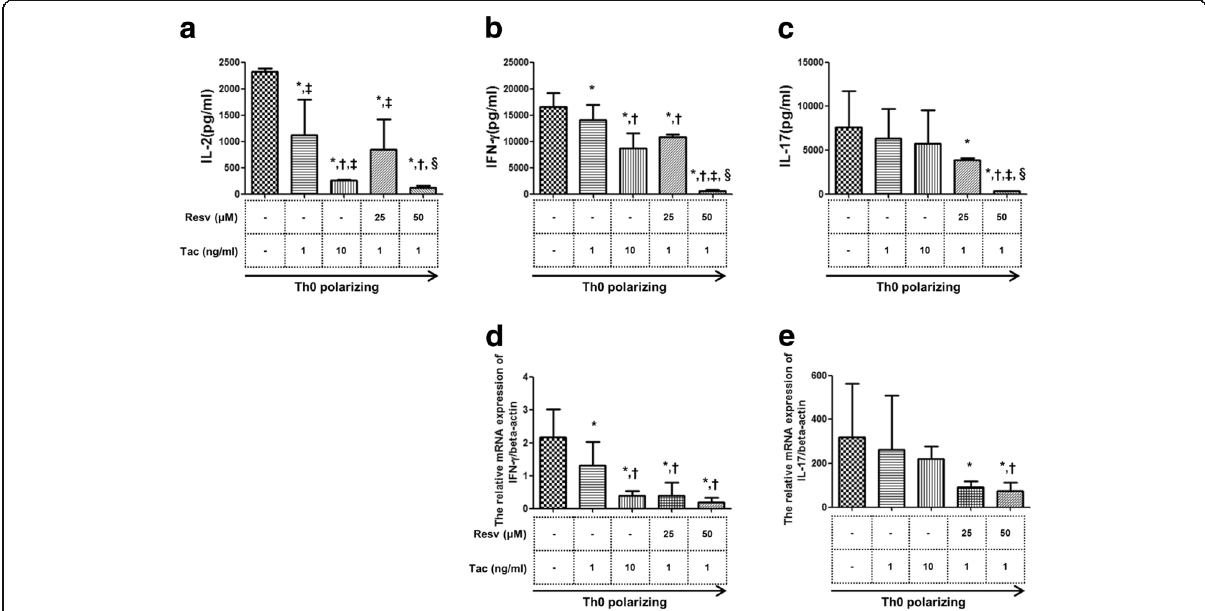
Fig. 2 The suppressive effects of Resv on inflammatory cytokine production and mRNA expression. The effects of Tac with or without Resv on the concentration of ( a ) IL-2 ( b ) IFN- γ ( c ) IL-17 in the culture-supernatant and effects on the e xpression of ( d ) IFN- γ ( e ) IL-17 mRNA measured using real-time PCR. Bars show the means * P < 0.05 vs. Th0 polarizing † P < 0.05 vs. Tac 1 ng/mL group ‡ P < 0.05 vs. Tac 10 ng/mL group § P < 0.05 vs. Tac 1 ng/mL + Resv 25 μ M group. Resv, Resveratrol; Tac,